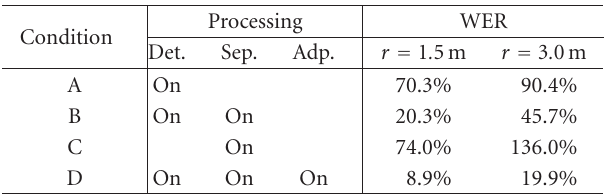
Figure 12: Input/separated waveform. The bars indicate the true and the detected speech events. (a) Input, (b) separated. Table 2: Detection rate. Table 3: Word error